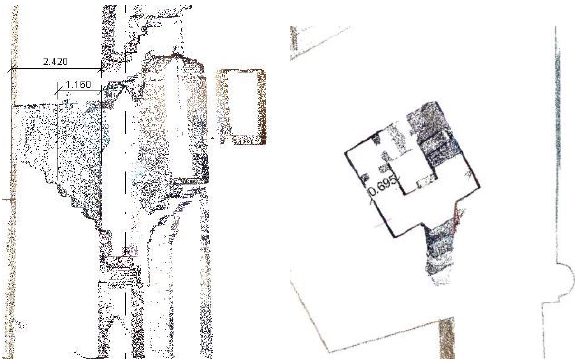
Figure 8. Measurement over the point cloud of the wall thickness and the width of the staircase at the meeting point of the two construction stages.